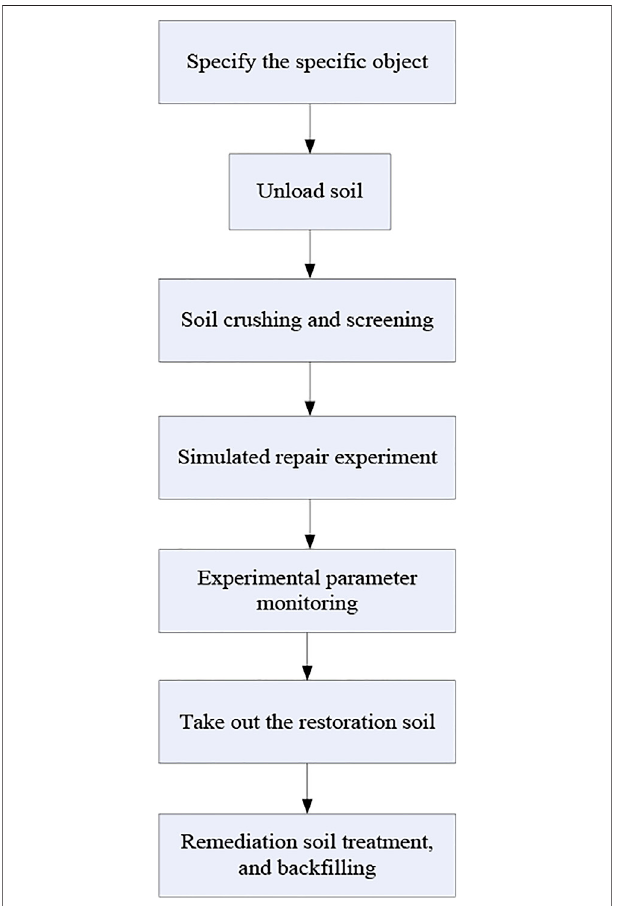
FIGURE 6 | Simulated soil remediation process.